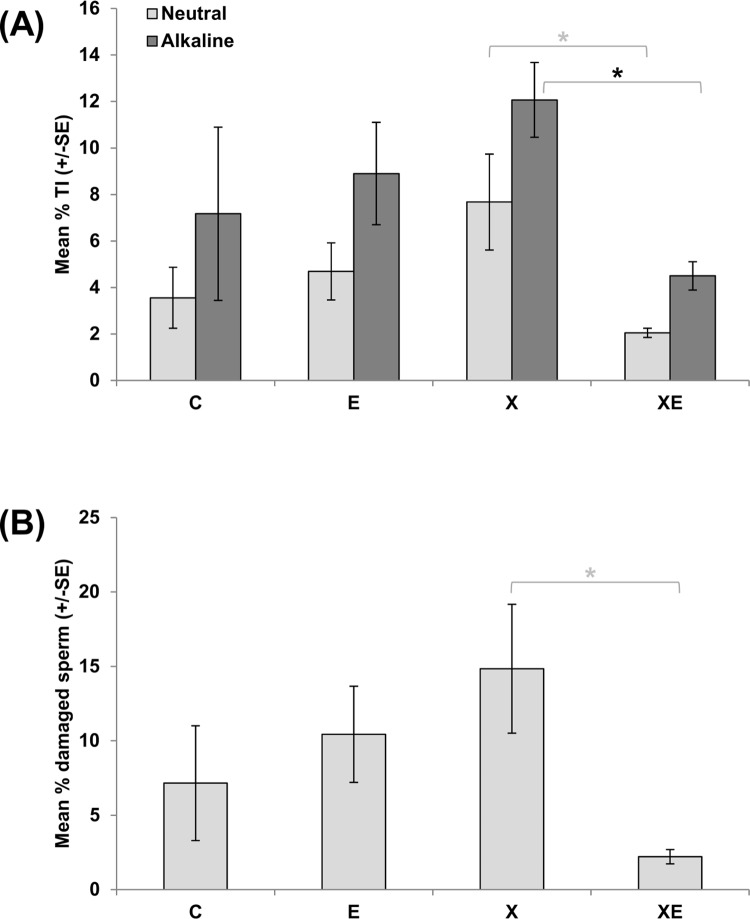
Comet assay in epididymal sperm.(A) Mean tail intensity values obtained with alkaline and neutral comet assay. (B) Percentage of sperm carrying clearly damaged DNA (with tail intensity values higher than 10%) after neutral assay. Columns represent the mean values of 4 controls (C), 5 ELF-MF exposed (E), 8 X-rays exposed (X), or 6 animals exposed to combined treatments (XE).